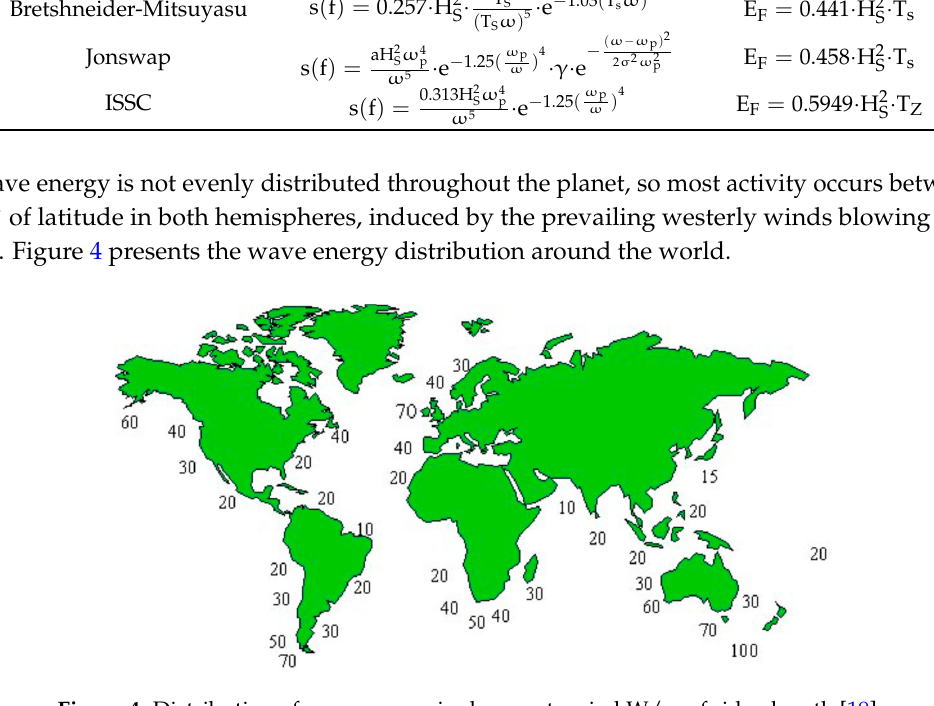
Figure 4. Distribution of wave energy in deep waters in kW/m of ridge length [19].